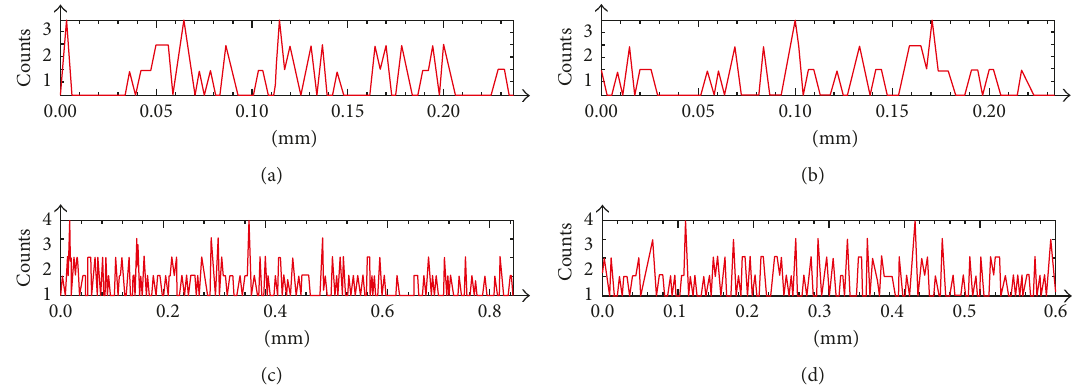
Figure 9: Elemental distribution of Zn, line scanning: (a) without annealing and annealing at (b) 200 ° C, (c) 250 ° C, and (d) 300 °